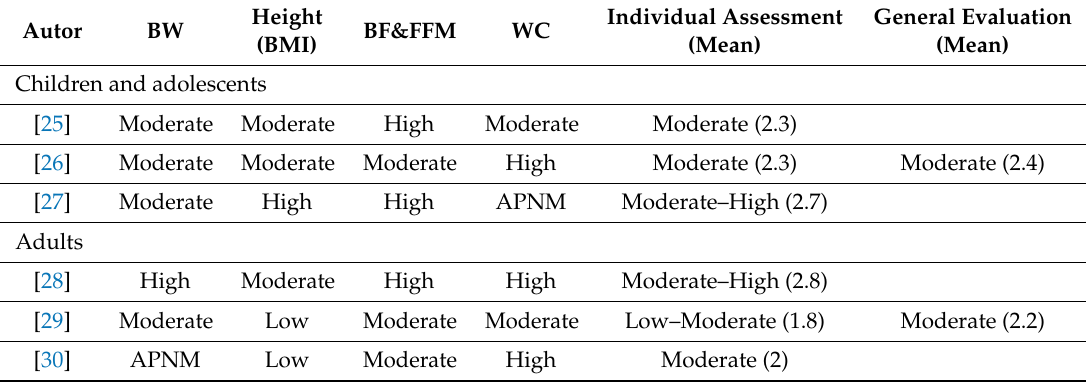
Table 4. Assessment of the level of information presented in the measurement of body